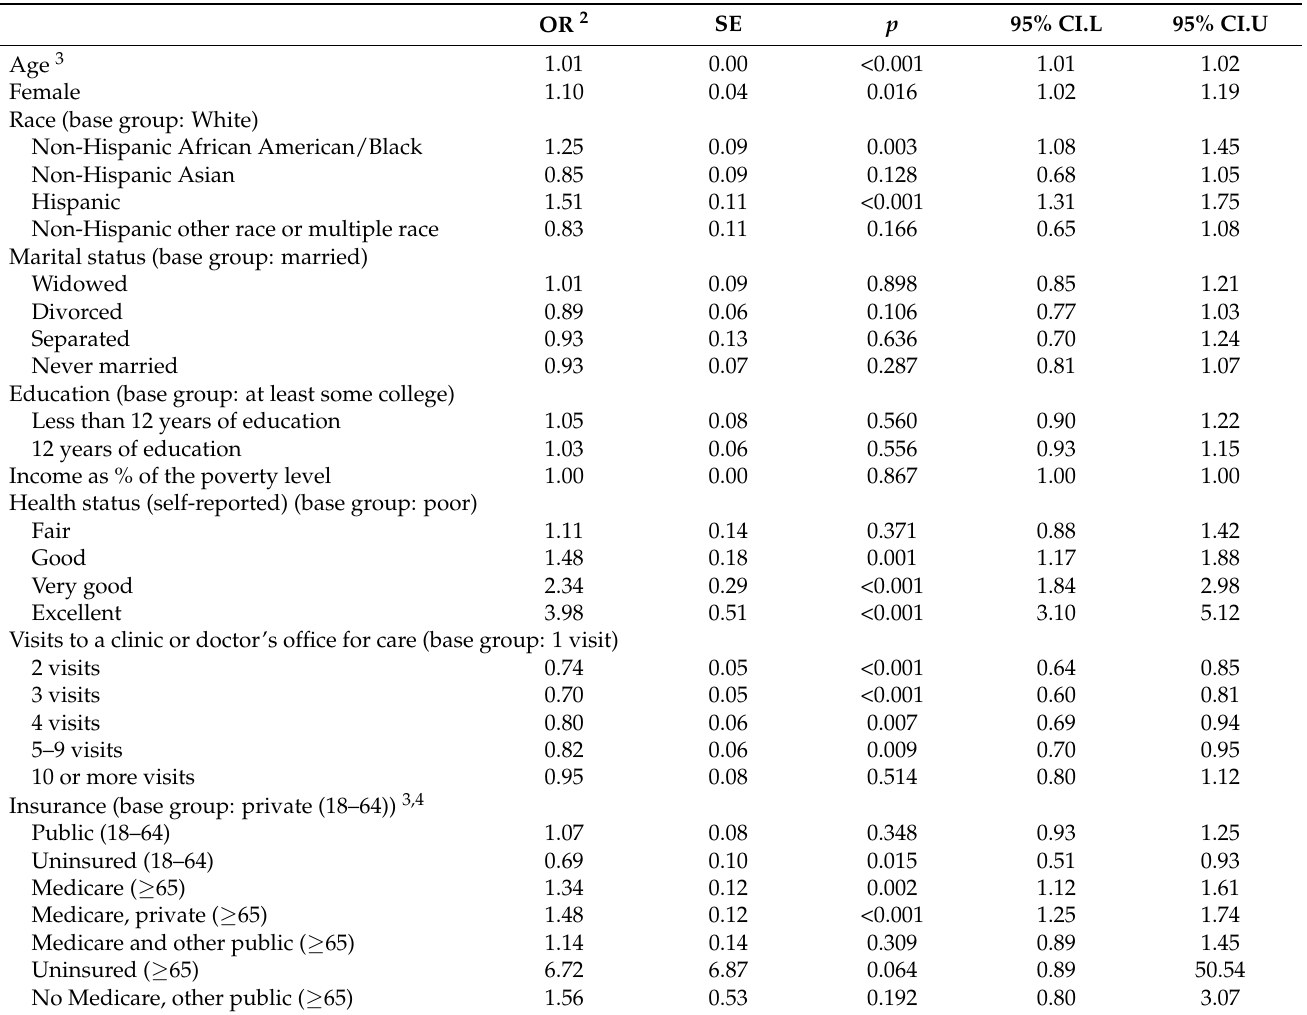
Table 2. Multiple logistic regression: possible predictors of a “Top Box” score of how patients rate their healthcare from their providers 1